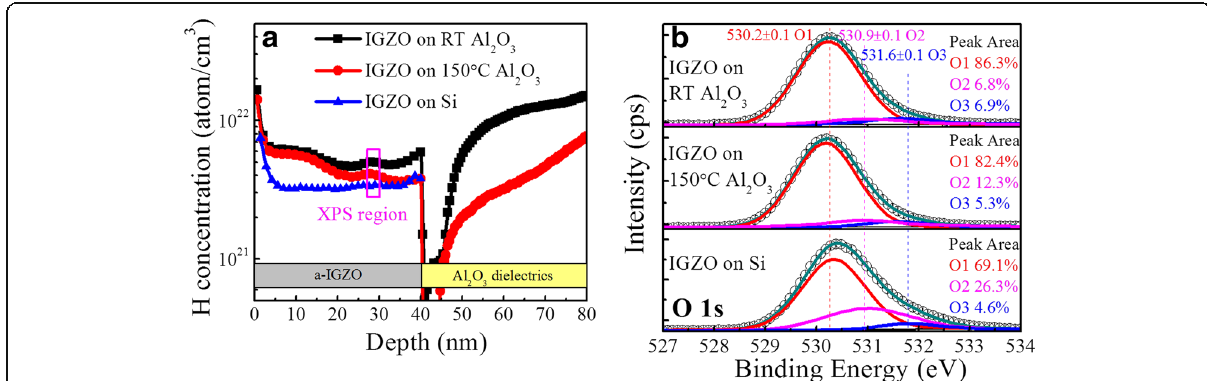
Fig. 5 a SIMS profiles of hydrogen concentration in Al 2 O 3 deposited at RT and 150 °C. b High-resolution O1s XPS spectra of the IGZO channel deposited on RT Al 2 O 3 , 150 °C Al 2 O 3 , and bare